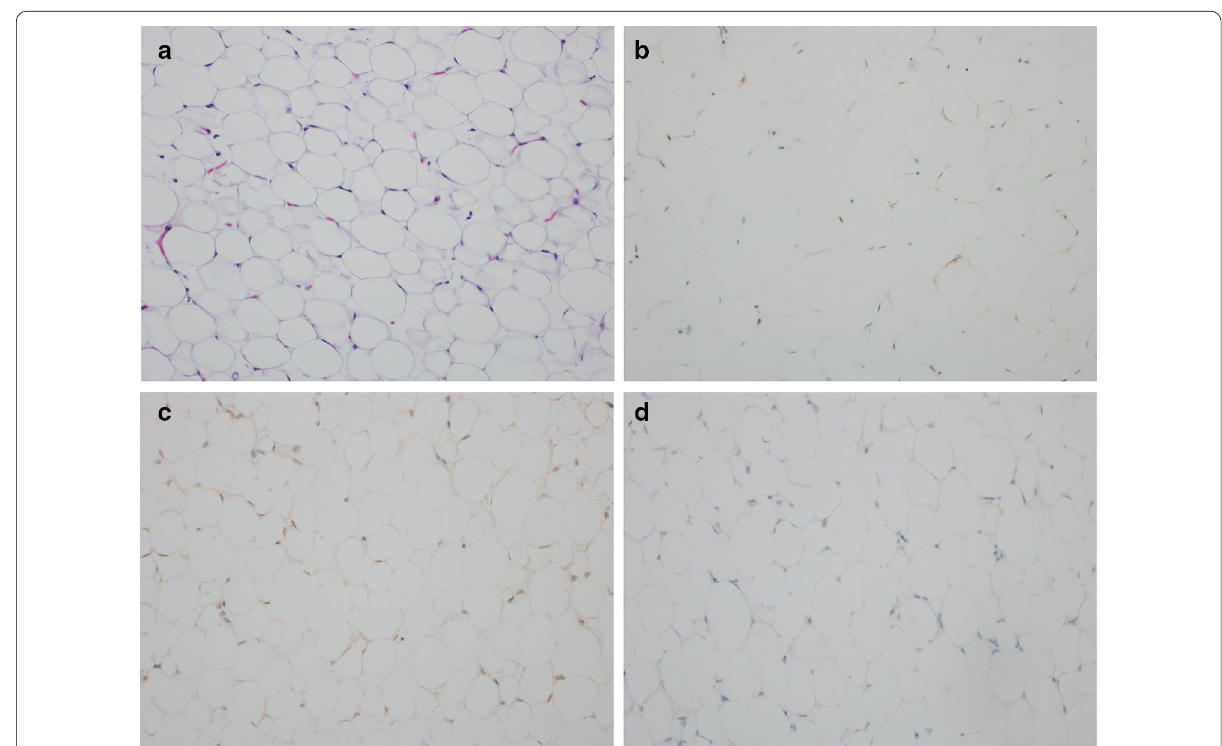
Fig. 4 A histopathologic examination revealed the tumor cells demonstrated the lobular proliferation of mature adipocytes ( a ). Immunohistochemistry results were as follows: adipocytic cells positive for p16 ( b ), positive for cyclin-dependent kinase 4 ( c ), and negative for murine double minutes ( d